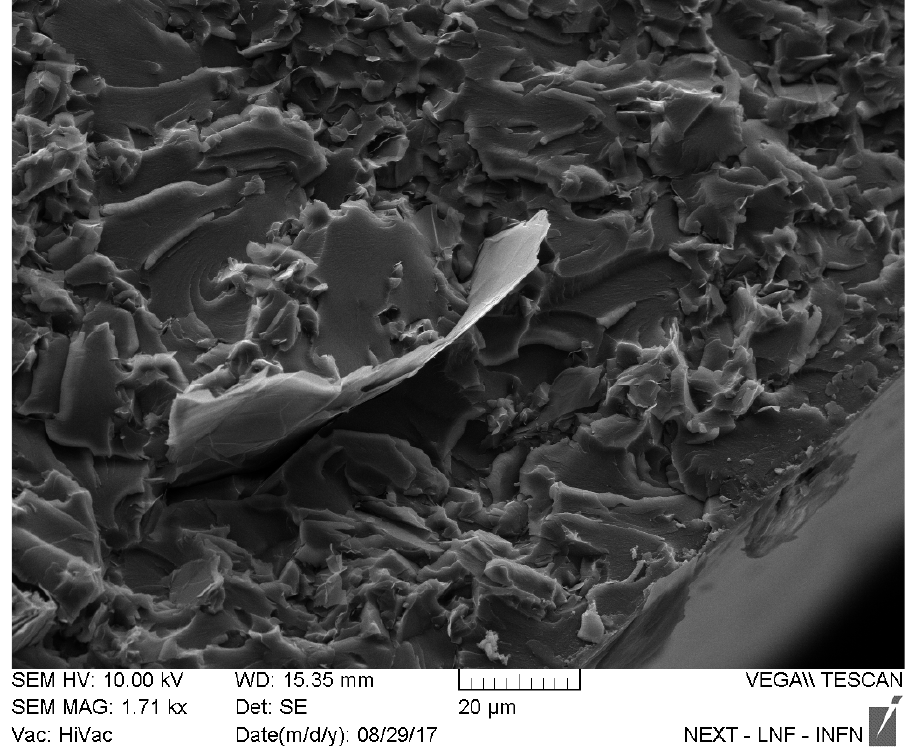
Figure 27. SEM image of thin film section at 1000 rpm with 0.5%GNP .